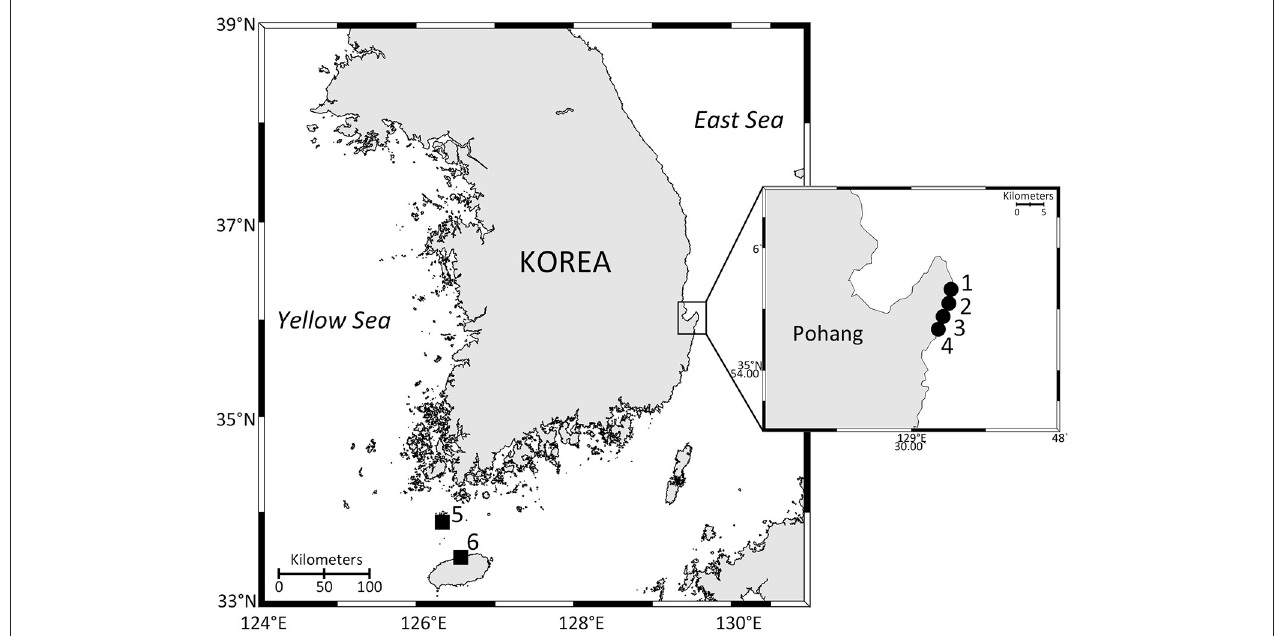
FIGURE 1 | Map of the study area showing the sampling sites. 1, Gangsa; 2, Samjeong; 3, Guryongpo; 4, Hajeong; 5, Chuja Island; 6, Jeju harbor. Closed circles are monitoring sites. Closed squares are sites where additional Ostreopsis cells were isolated from the concentrated planktonic